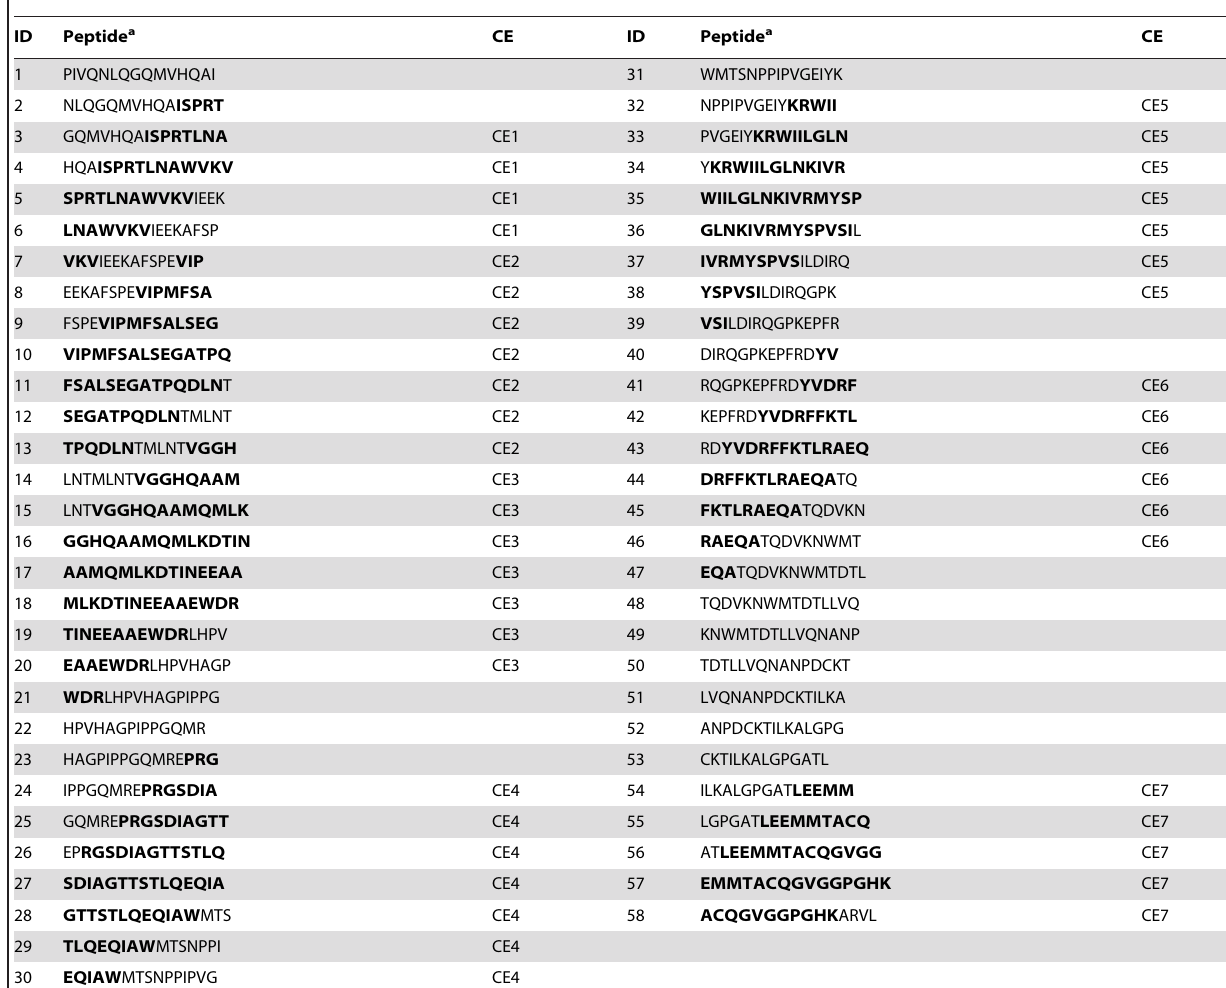
Table 1. Peptide list and coverage of